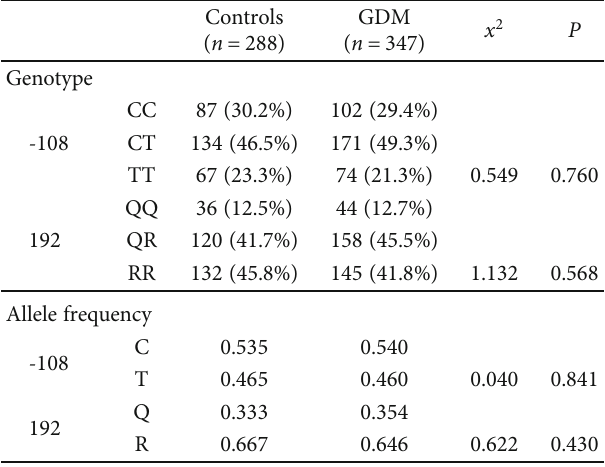
Table 3: Frequencies of PON1 genotype and allele in the women with GDM compared with the women with uncomplicated